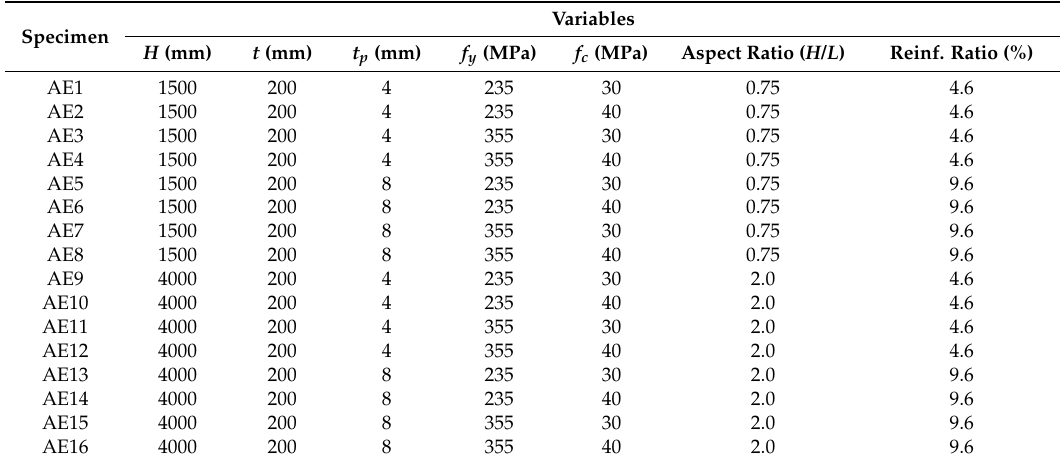
Table 3. Dimensions and material properties of specimens in the parametric